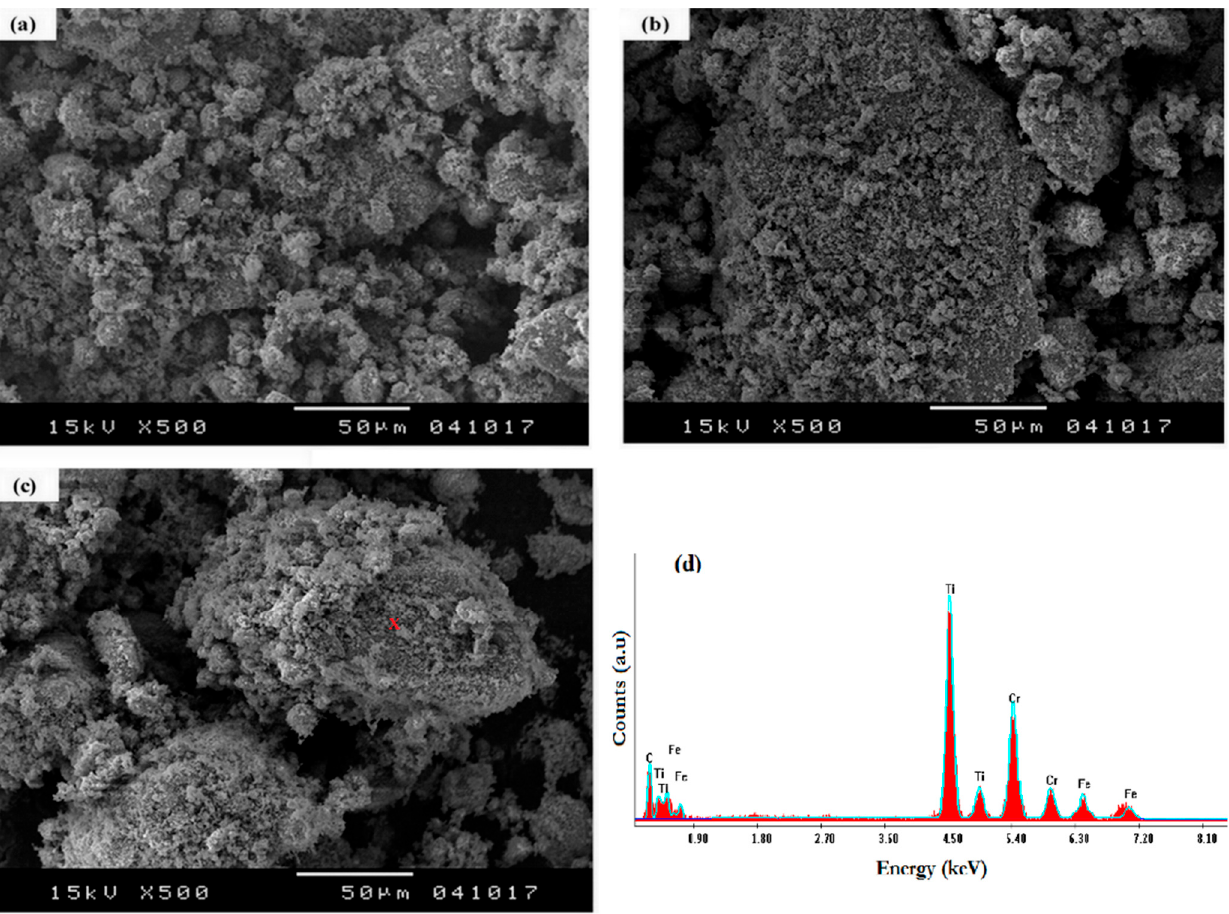
Figure 3. SEM micrographs of samples after MA for 5 h ( a ); 10 h ( b ); and 20 h ( c ). ( d ) An exemplary EDX spectrum taken form the sample milled for 20 h (zone marked with X).